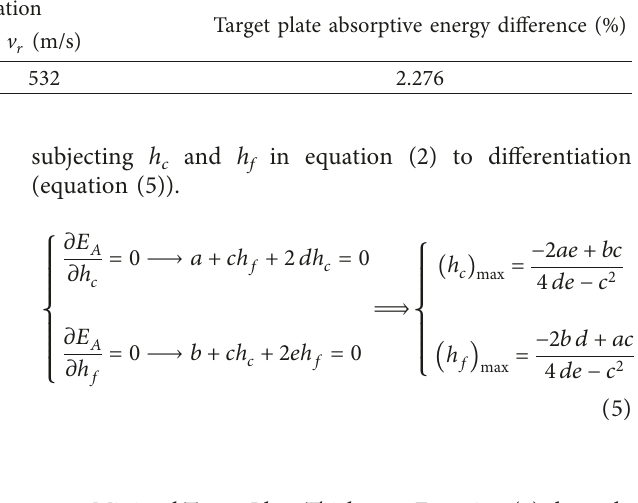
Table 8: Test data.